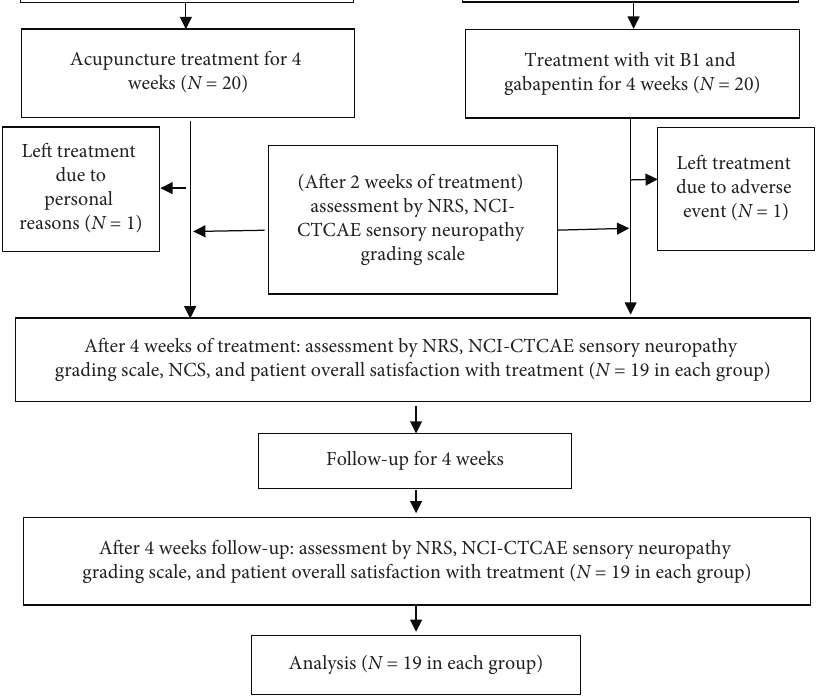
Figure 1: Flowchart of the study. MS: multiple sclerosis, CIPN: chemotherapy-induced peripheral neuropathy, NRS: Numerical Rating Scale, NCS: nerve conduction study, NCI-CTCAE: National Cancer Institute-Common Terminology Criteria for Adverse